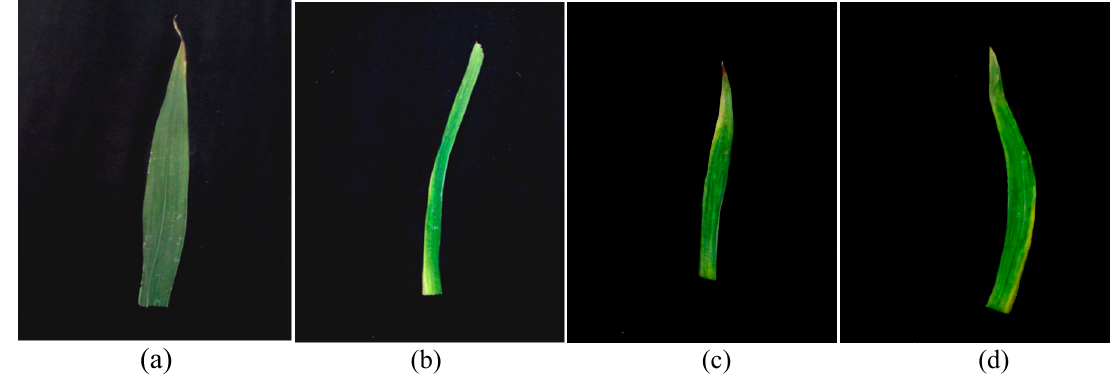
Figure 4. Impact of polyploidy on leaf color in gladiolus cv. White Prosperity: Leaves of dark green color have been produced in control plants ( a ) however, yellowish green (chlorine) have been developed at 0.1% ( b ), 0.2% ( c ) and 0.3% colchicine ( d ).